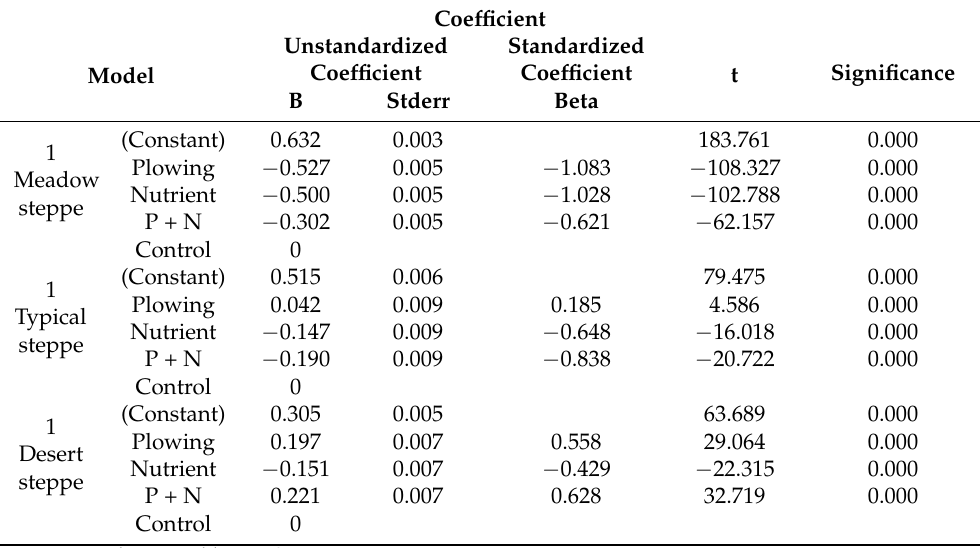
Table 2. Linear regression analysis of soil microbial biomass carbon.